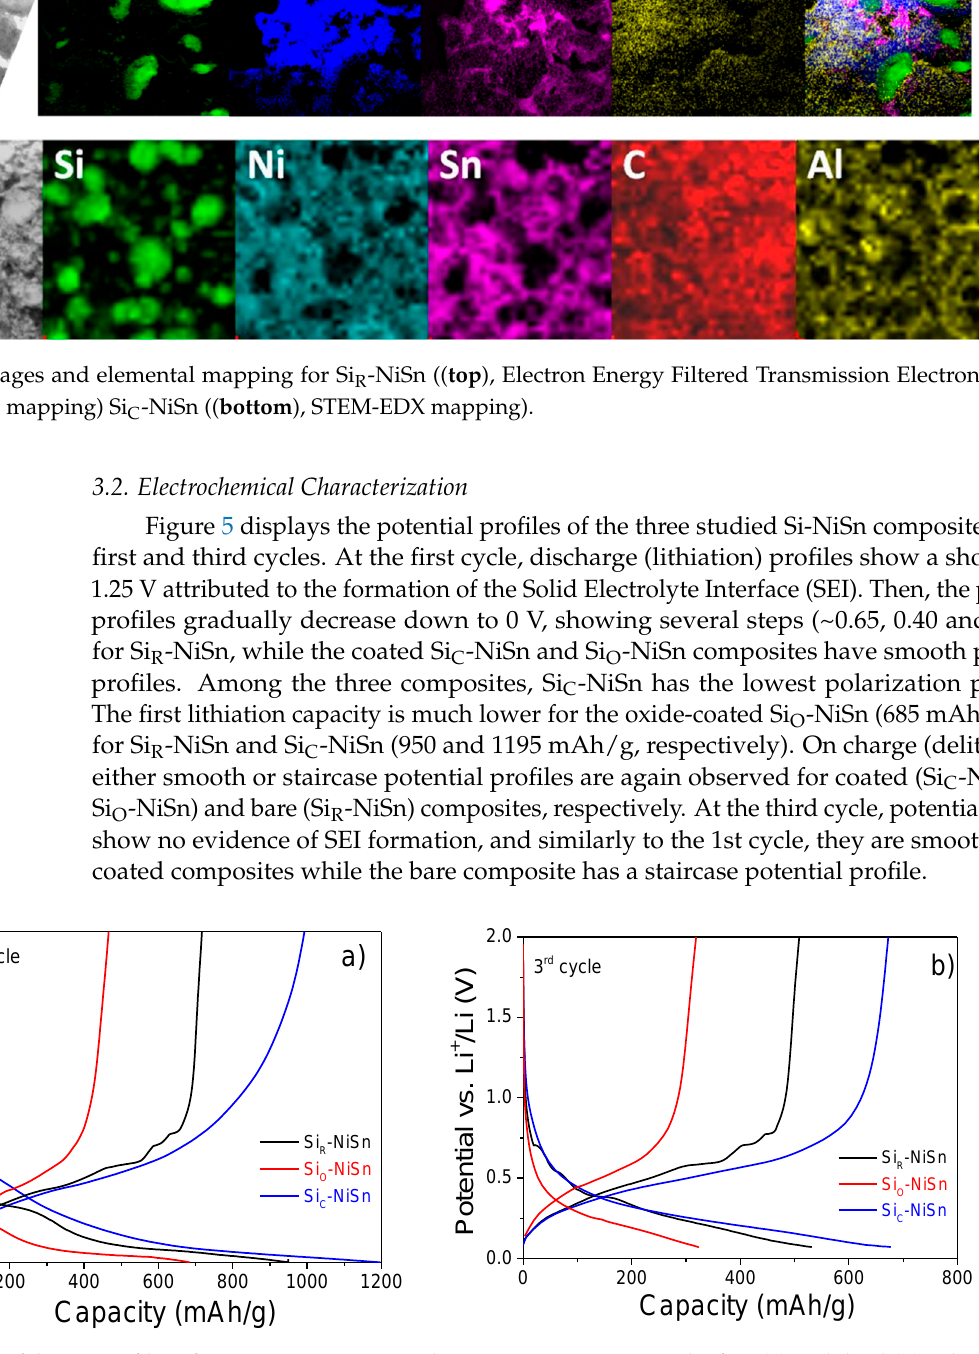
Figure 5. Discharge/charge profiles of Si R -NiSn, Si O -NiSn and Si C -NiSn composites at the first ( a ) and third ( b ) galvanostatic cycle.